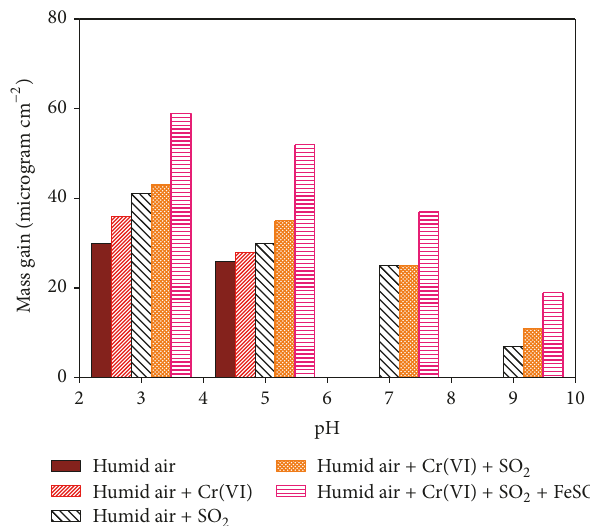
Figure 4: Total mass gain ( 𝜇 gcm −2 ) and corresponding conditions as a function of pH after 60 days of